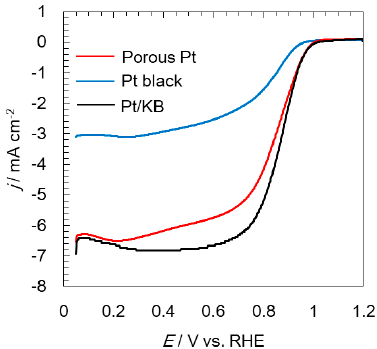
Figure 4. Linear sweep voltammograms showing the oxygen reduction reaction (ORR) of porous Pt, Pt black, and Pt/KB at 1600 rpm under oxygen saturation.